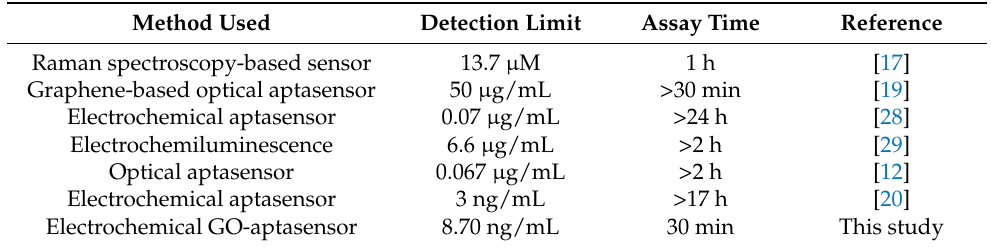
Table 2. Comparison of the Detection Limits and Assay Times of the Developed Aptasensor in This Study and Other GHSA Detection Platforms.